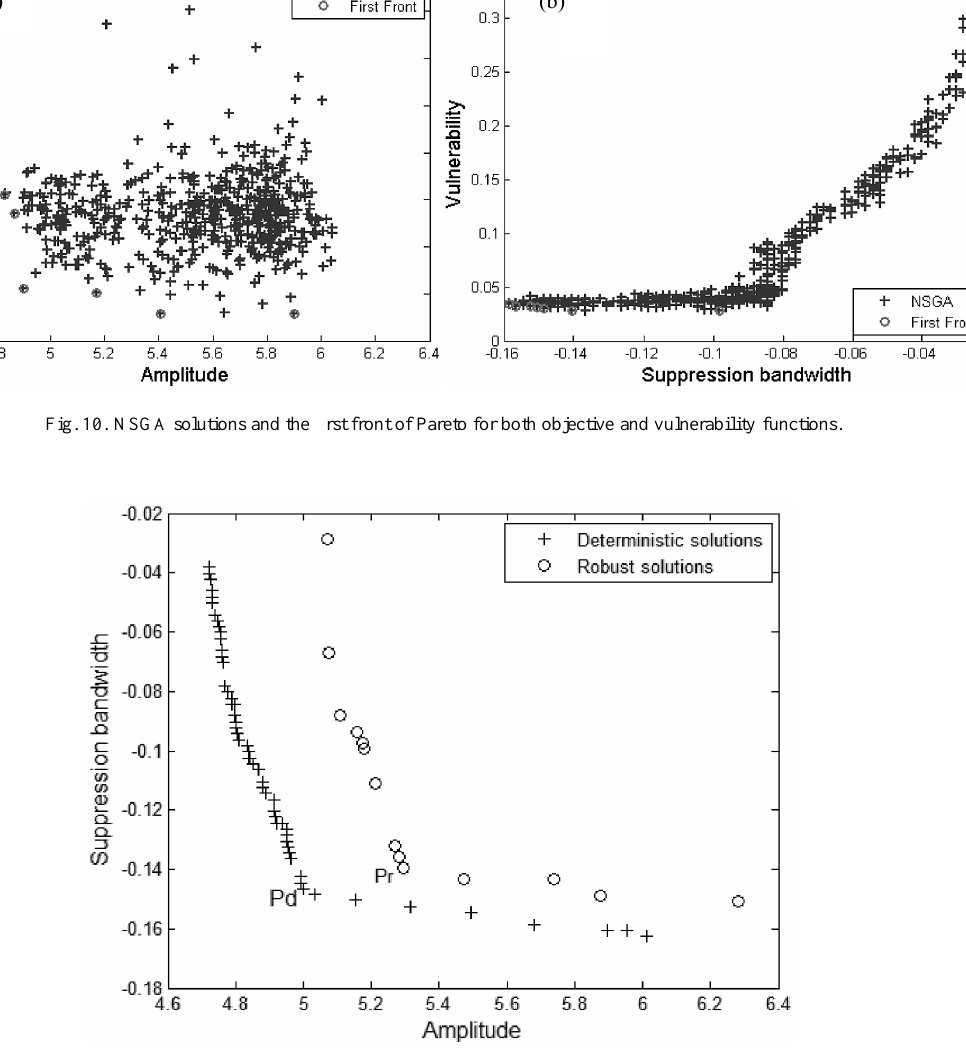
Fig. 11. Comparison between the deterministic solutions and the robust